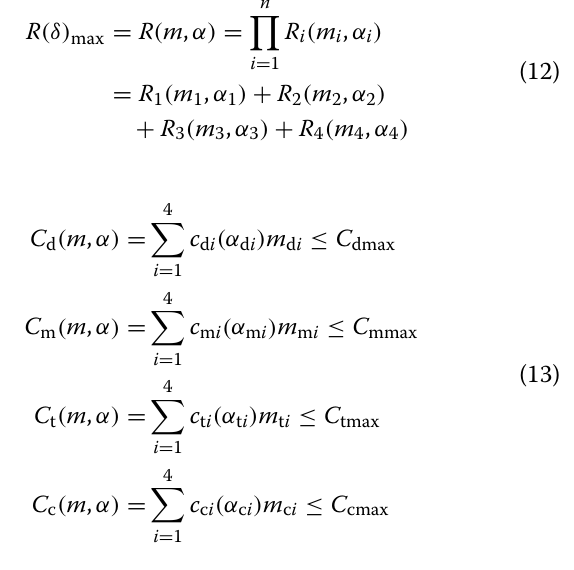
Table 1 Definition of the selected unconstrained and constrained test function Test